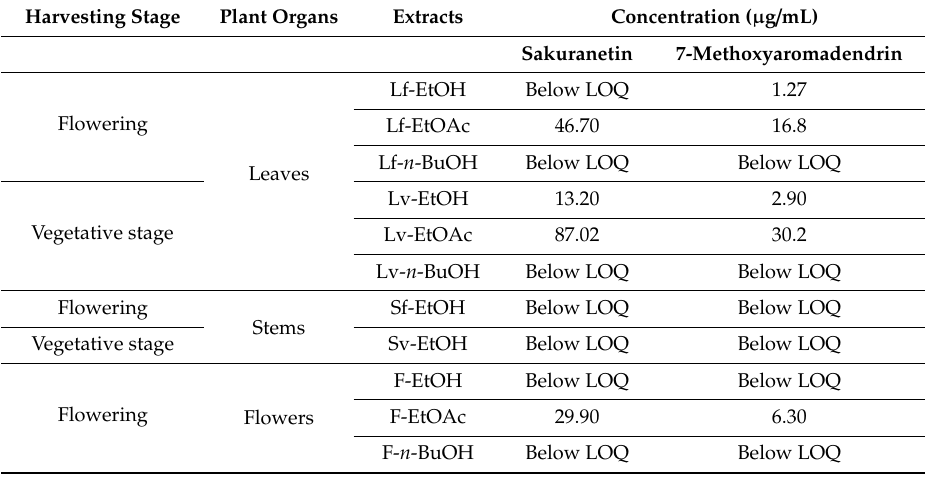
Table 3. Concentrationofsakuranetinand7-methoxyaromadendrinintheextractsbyUPLC / ESI / TQD / MS n . Harvesting